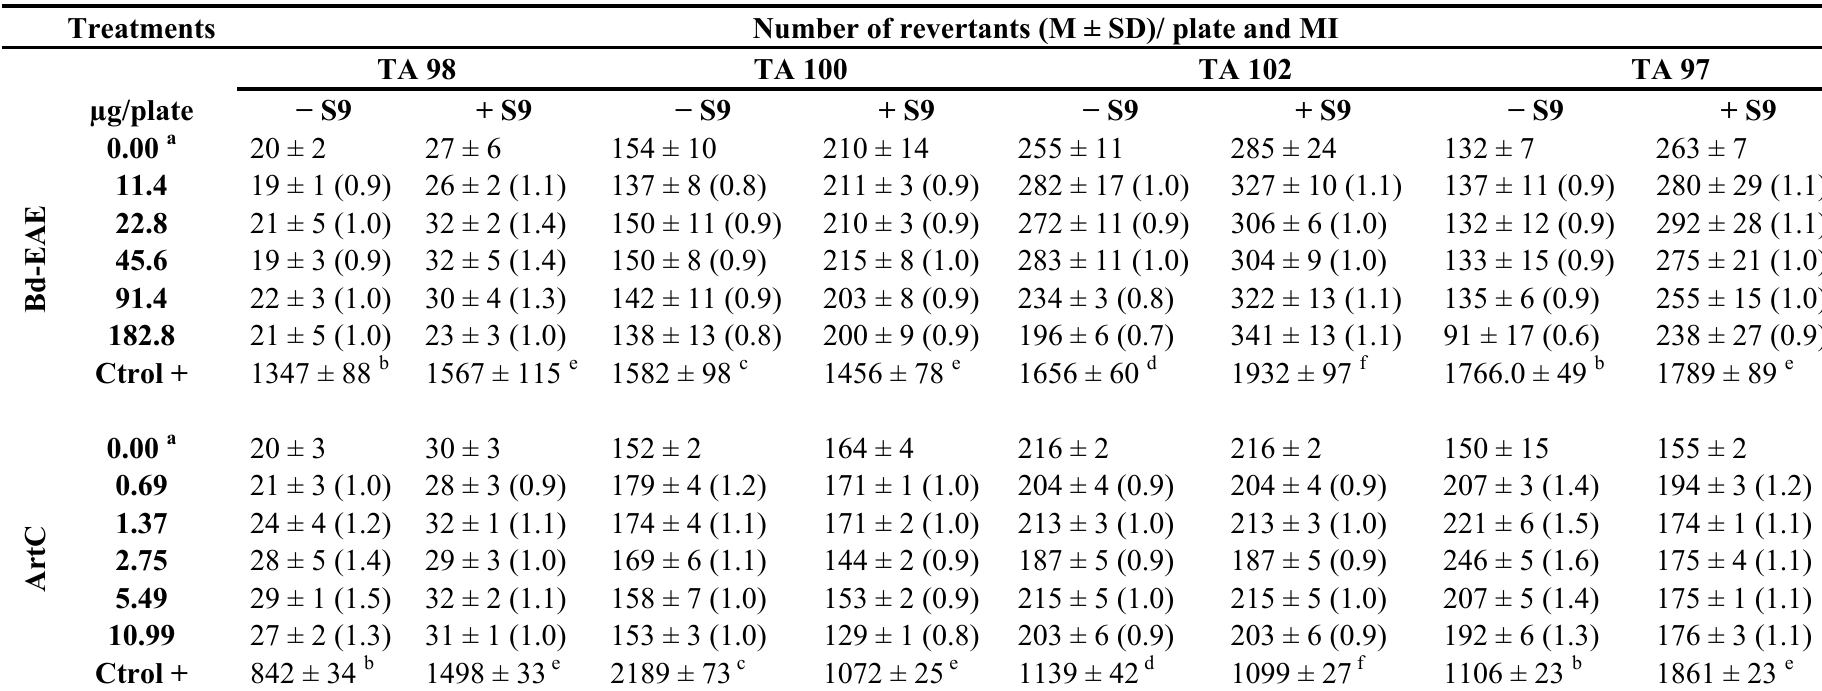
Bd-EAE = ethyl acetate extract of B. dracunculifolia leaves; ArtC = artepillin C; M ± SD = mean and standard deviation; MI = mutagenicity index; a Negative control: dimethylsulfoxide (DMSO - 50 μ L/ plate); Ctrol + = Positive control; b 4-nitro- o -phenylenediamine (NOPD – 10.0 μ g/ plate –